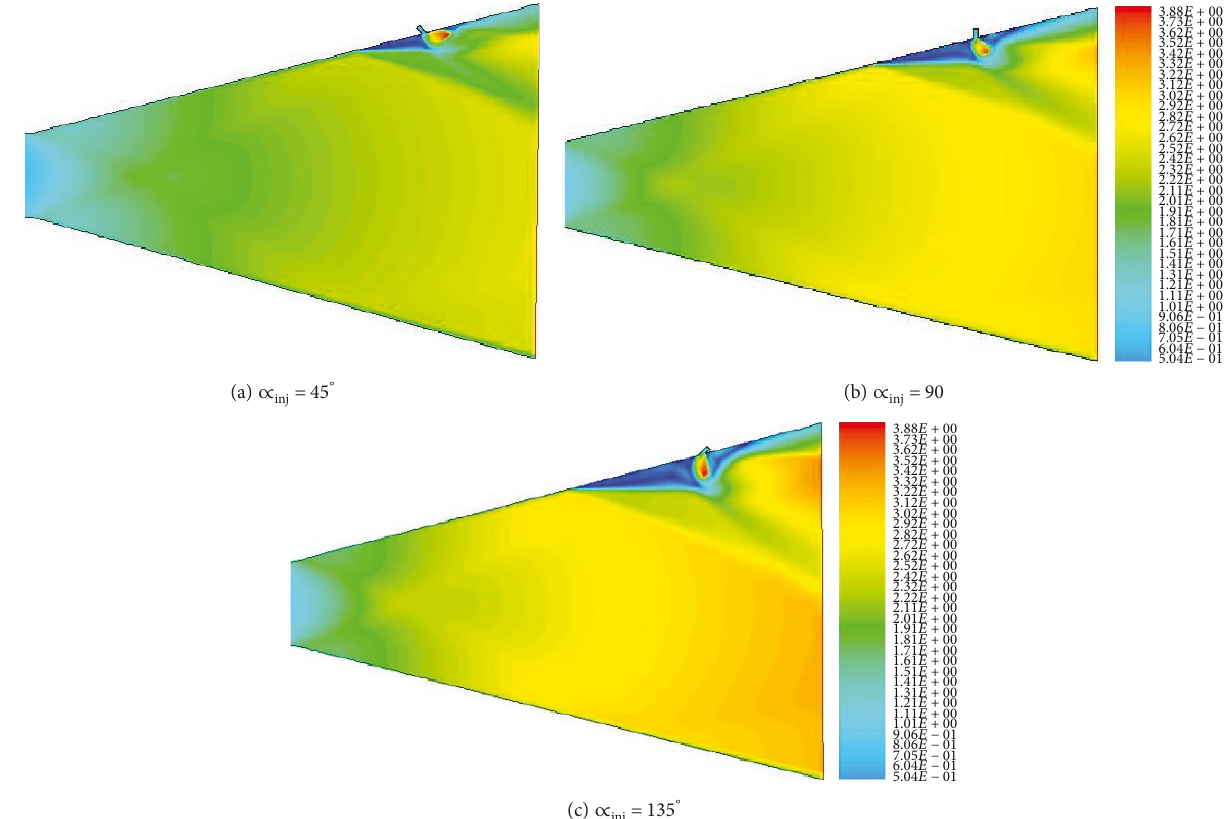
Figure 15: The in fl uence of injection angle on fl ow fi eld structure (Mach number contour) M